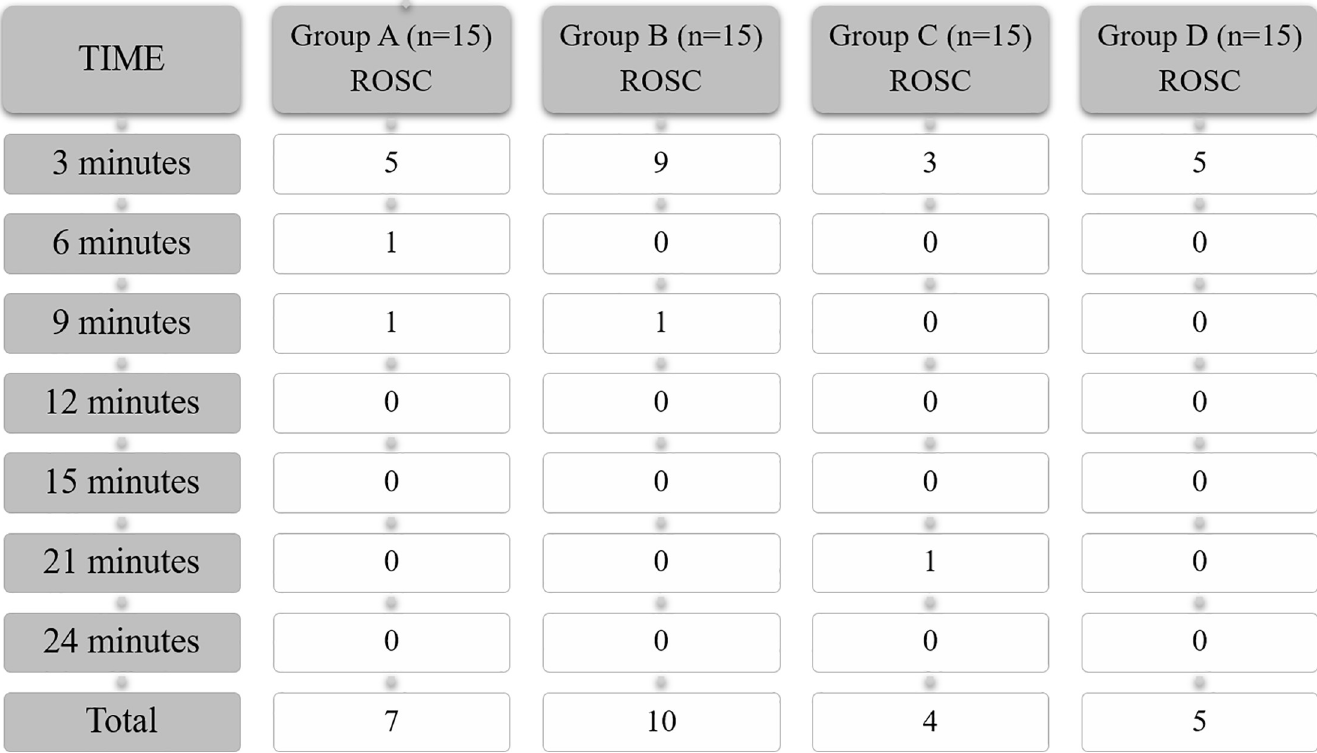
Fig 2. Recovery of spontaneous circulation (ROSC) timeline. Number of piglets that have achieved ROSC at different times of resuscitation. ROSC: Recovery of spontaneous circulation. https://doi.org/10.1371/journal.pone.0219660.g002 Table 2. Comparison of hemodynamic and respiratory parameters at three minutes of CPR (median and interquartile range).